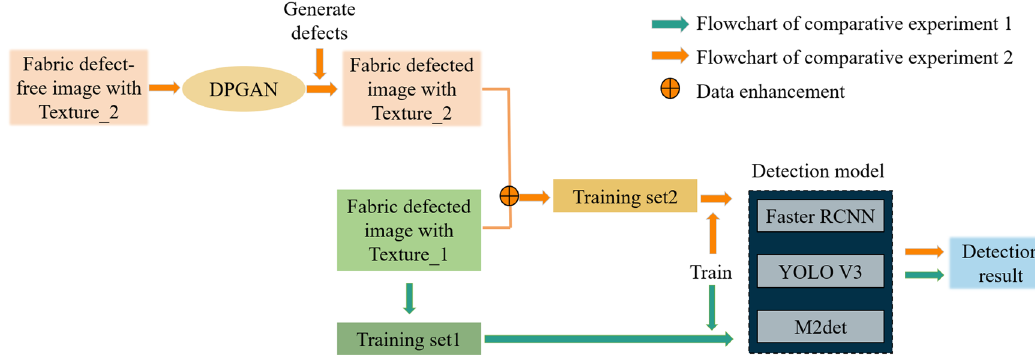
Figure 5: The fl owchart of the fabric detection